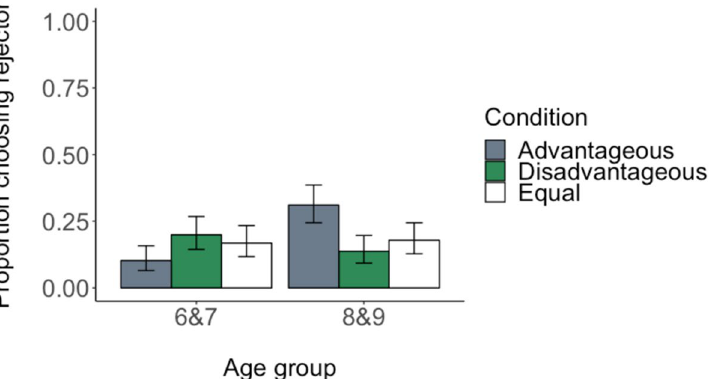
Figure 3. Proportion of trials in which children chose the partner who rejected an allocation across advantageous, disadvantageous and equal conditions. Proportions are shown by age group. Error bars show confidence